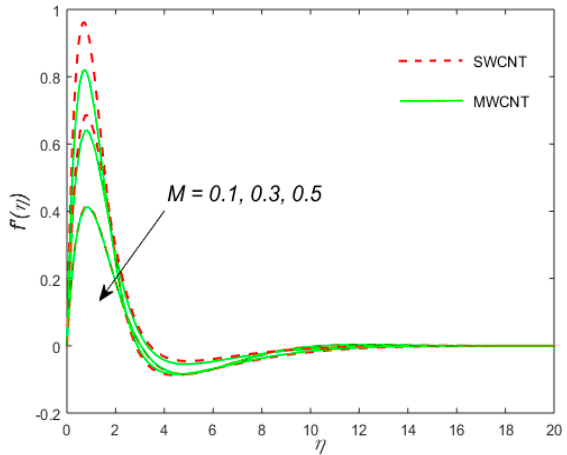
Figure 3. The variation of the velocity distribution profile f’ ( η ) for the case of SWCNT and MWCNT versus the similarity variable for the distinct values of the magnetic parameter ( M ).